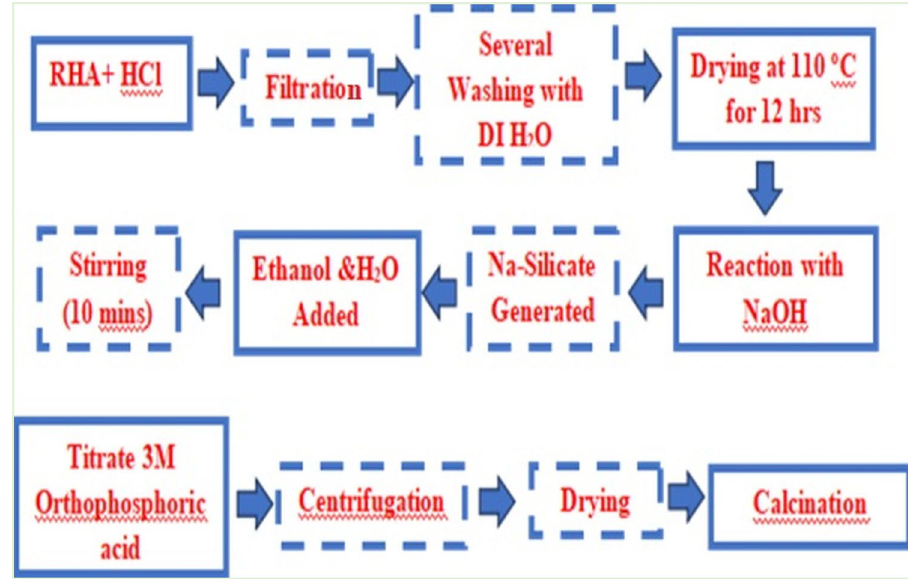
Fig. 4 Schematic representa- tion of the extraction procedure of silica from RHA (Adapted from Zulkifli et al .,